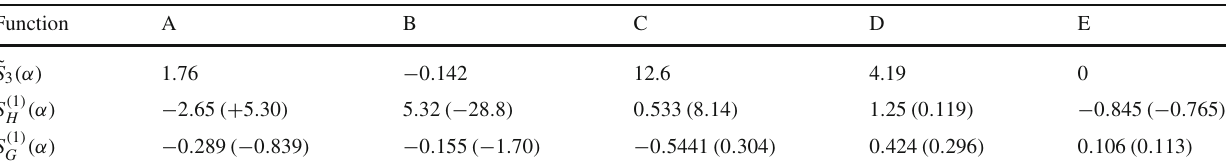
ranges. The number not in the parenthesis applies for 0 ≤ α ≤ 0 . 8; and the number in the parenthesis applies for 1 ≥ α ≥ 0 .